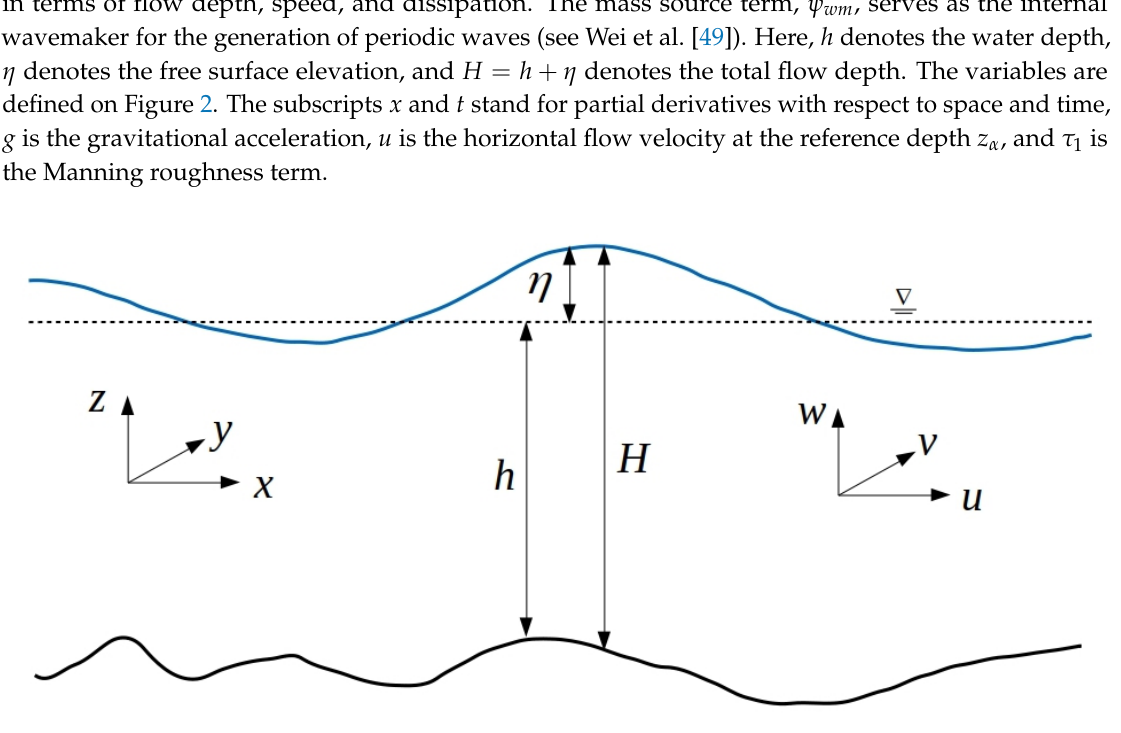
Figure 2. Definition sketch of the free surface